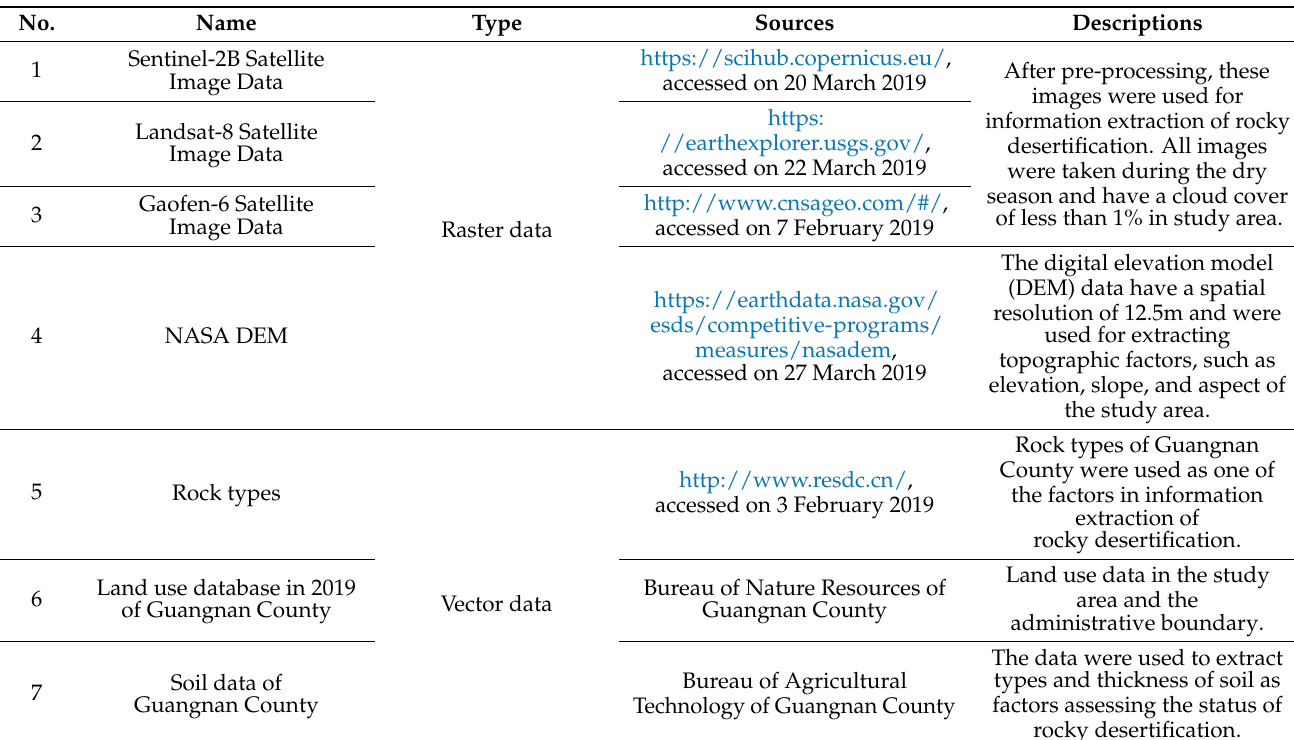
Table 1. Data sources and